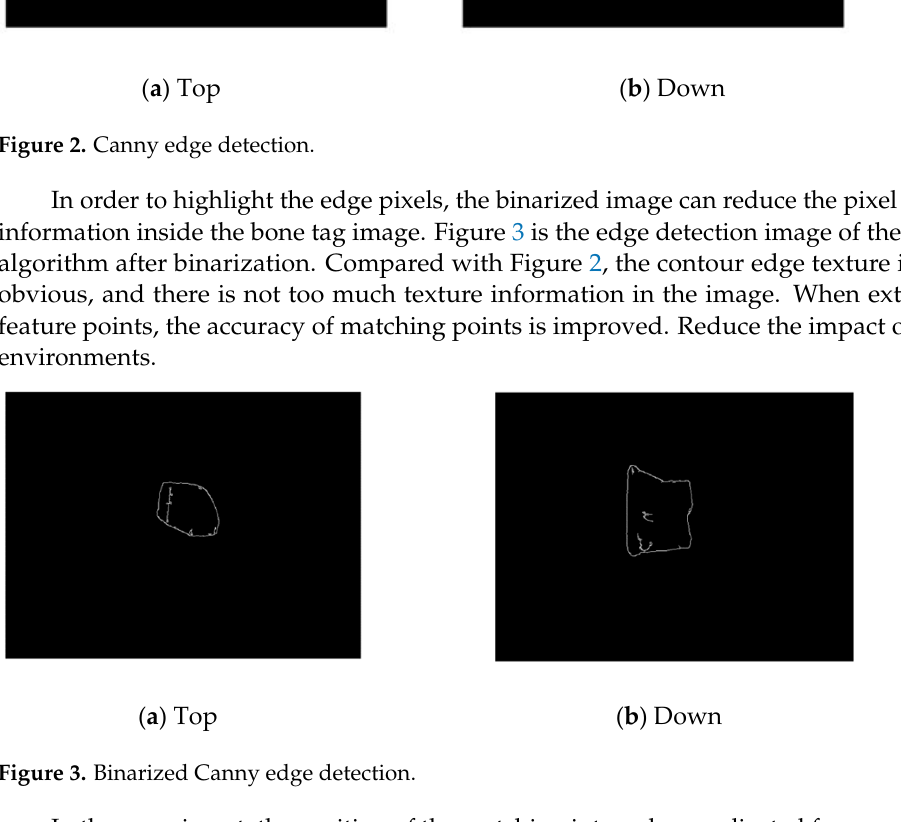
Figure 4. ORB feature extraction.